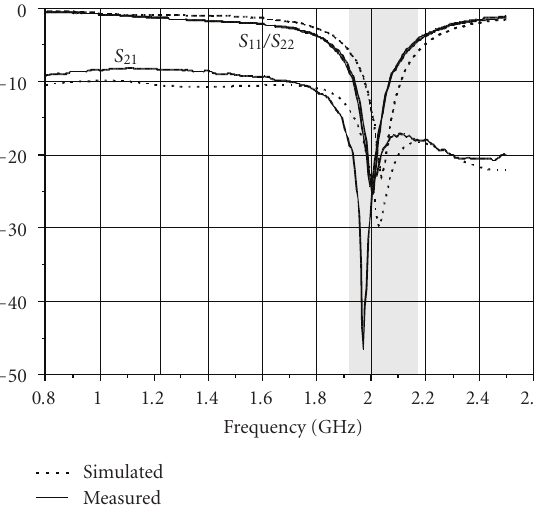
Figure 2: Simulated and measured S -parameters of the initial two- antenna system.